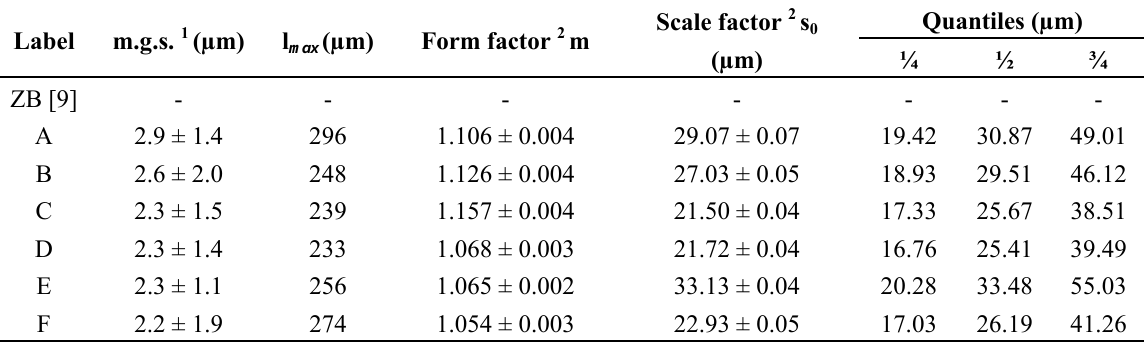
Table 2. Sample label, mean grain size (m.g.s.), maximum fiber length (l (m), scale factor (s ) and 0